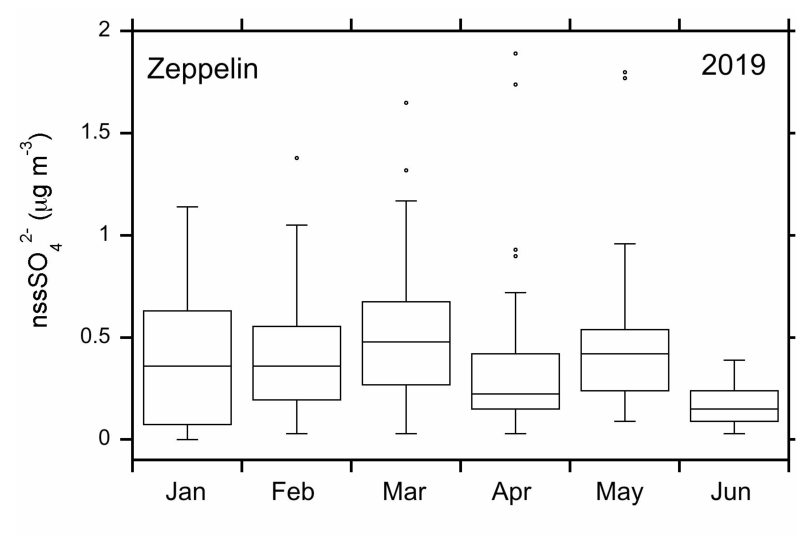
Figure 13. SO 2 − concentration from Zeppelin station. 4